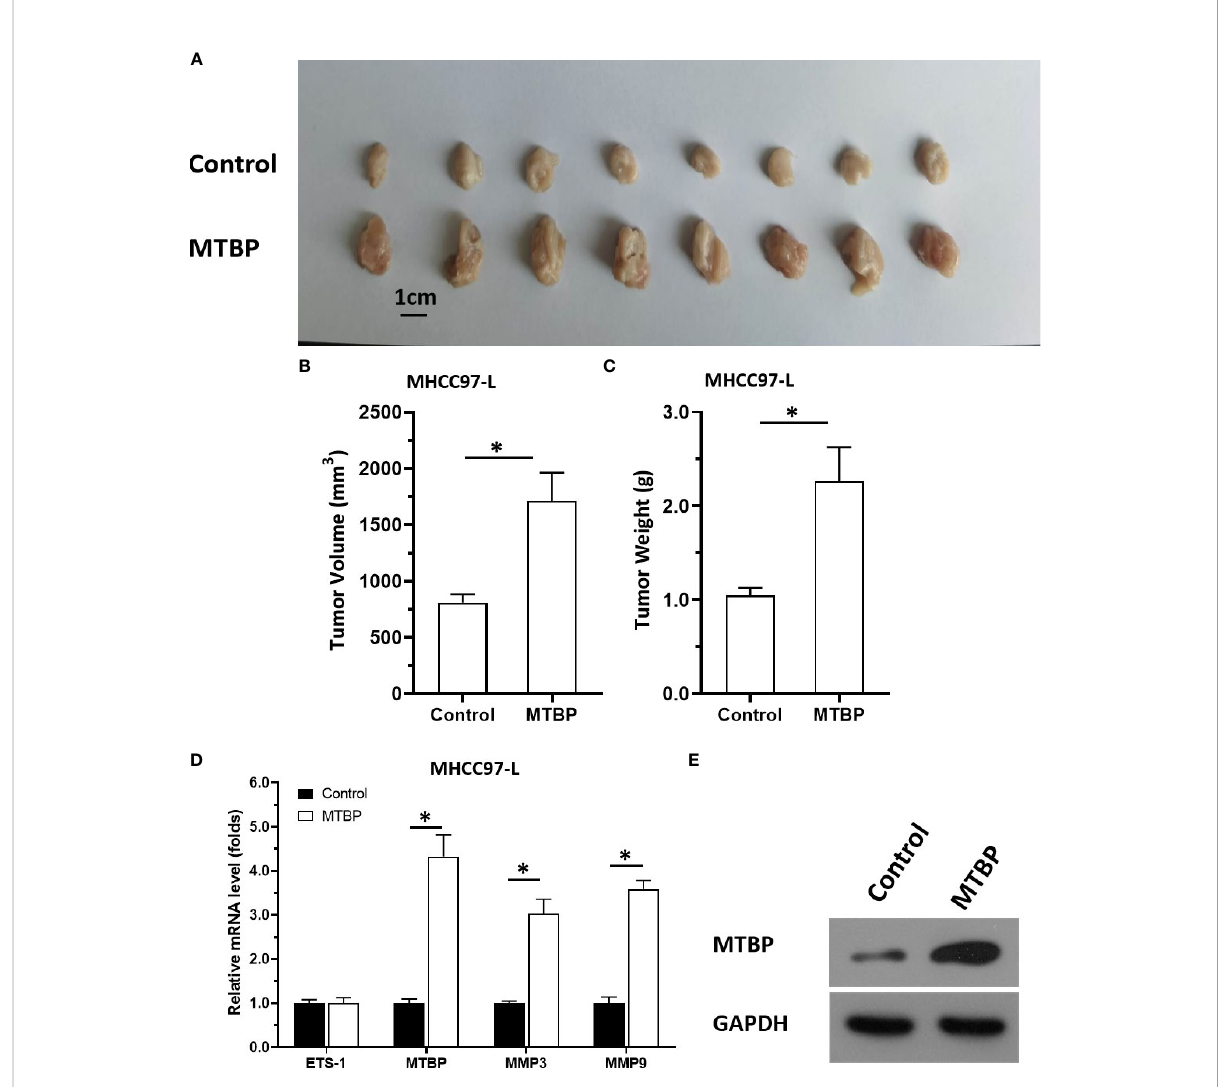
FIGURE 9 Overexpression of MTBP enhances in vivo growth and ETS-1 activation in HCC tumor tissues. MTBP was overexpressed in MHCC97-L cells via stable transfection, and cells were injected into nude mice to form subcutaneous tumor tissues. (A) the tumor tissues formed by MHCC97-L cells overexpressed MTBP. (B, C) the volumes or weights of tumor tissues formed by MHCC97-L cells overexpressed MTBP. (D) the expression level of ETS-1, MTBP, MMP3 or MMP9 in the tumor tissues. (E) the images of western blot was shown to indicate the stable transfection of MTBP. *P <